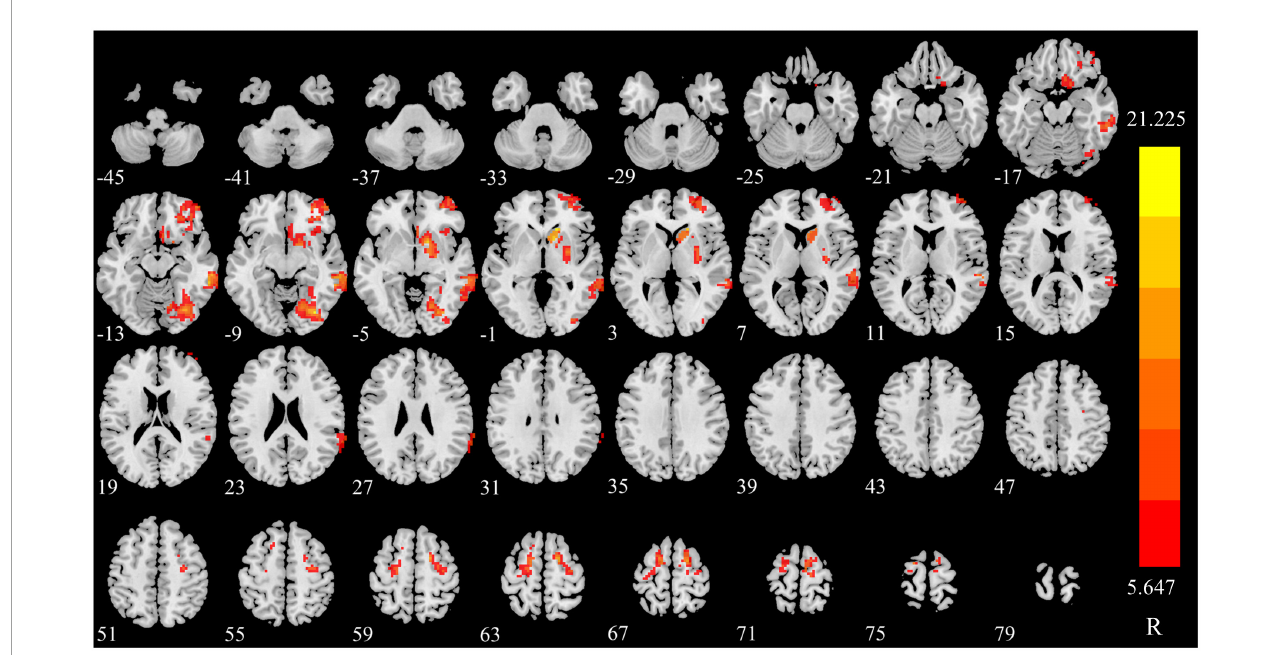
FIGURE2 Significant differences in sDC among different time points in patients with CTN. sDC, static degree centrality; CTN, classical trigeminal neuralgia.